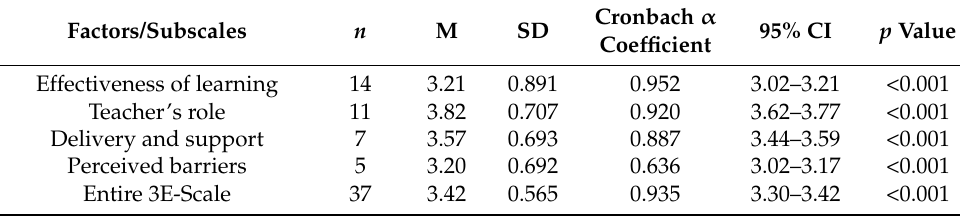
Cronbach α Coefficient